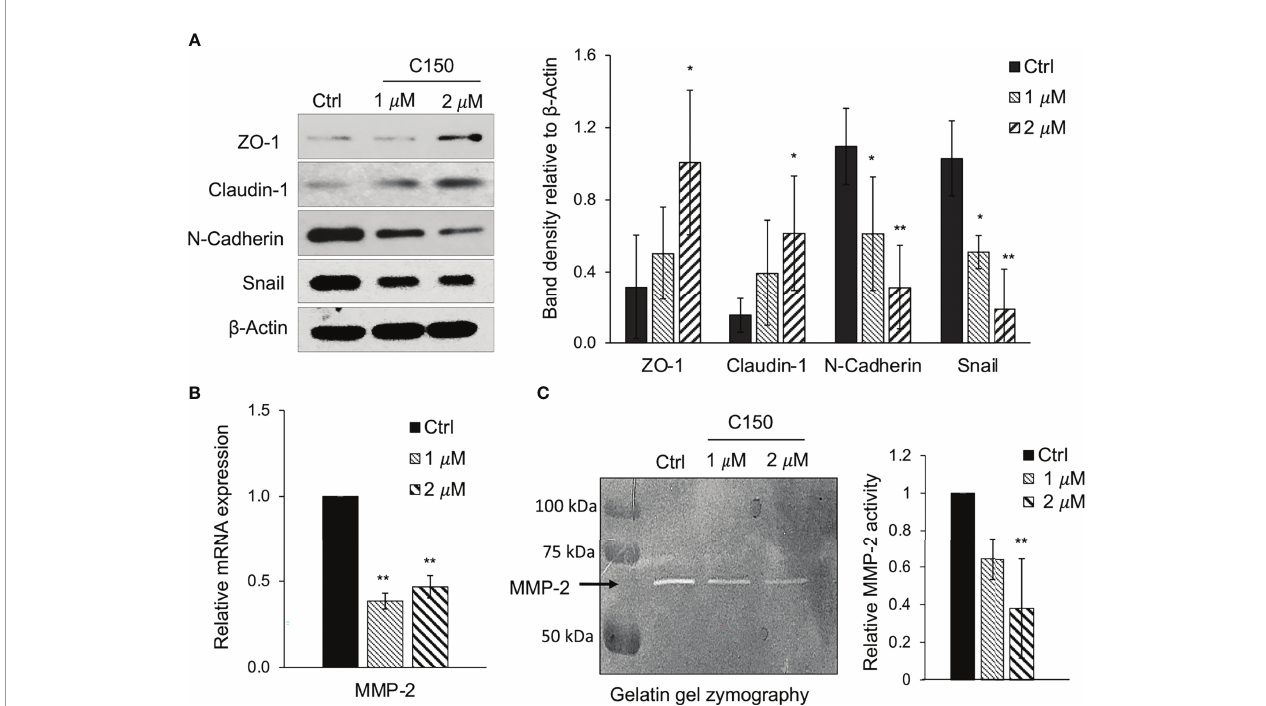
FIGURE 3 | C150 inhibits EMT in PANC-1 cells. (A) Western blots of EMT markers. PANC-1 cells were treated with DMSO (Ctrl) or C150 (1 and 2 m M) for 24 h. Total cell lysates were subjected to immunoblotting against ZO-1, claudin-1, Snail and N-cadherin. b -Actin was blotted as loading control. Bar graph shows the band densities relative to b -actin. (B) mRNA expression levels of MMP-2. PANC-1 cells were treated with DMSO (Ctrl) or C150 (1 and 2 m M) for 24 h. Reverse transcription-quantitative PCR results were quanti fi ed and normalized to the Ctrl group using the 2 - dd Cq method with GAPDH as the housekeeping gene. (C) MMP-2 activity in gelatin zymography assay. PANC-1 cells were treated with DMSO (Ctrl) or C150 (1 and 2 m M) for 24 h in FBS-free medium. The supernatant was then analyzed in gelatin gel and subjected to enzyme activity zymography assay. Bright bands represent MMP-2 enzyme activity. Bar graph shows the relative enzyme activity normalized to the Ctrl group. Data are presented as mean ± SD of at least three independent experiments in all graphs. *P < 0.05, **P < 0.01 (vs. Ctrl) by one-way ANOVA followed by Tukey ’ s post hoc test. C150, 2-[2-(5-nitro-2-thienyl)vinyl]quinoline; Ctrl, control; EMT, epithelial-to- mesenchymal transition; ZO-1, zonula